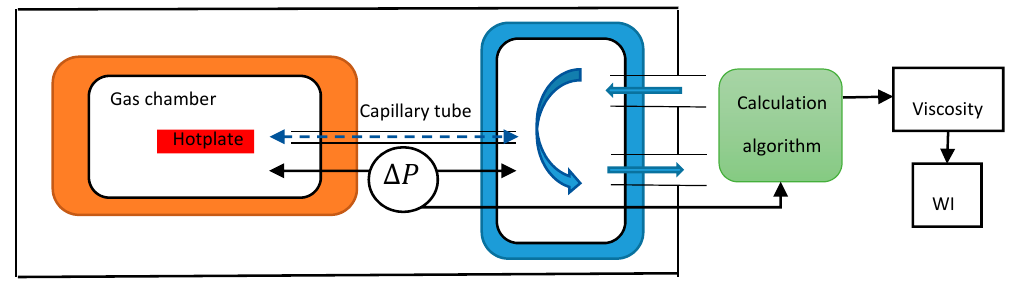
Figure 1. Schematic of the sensor and its working principle.